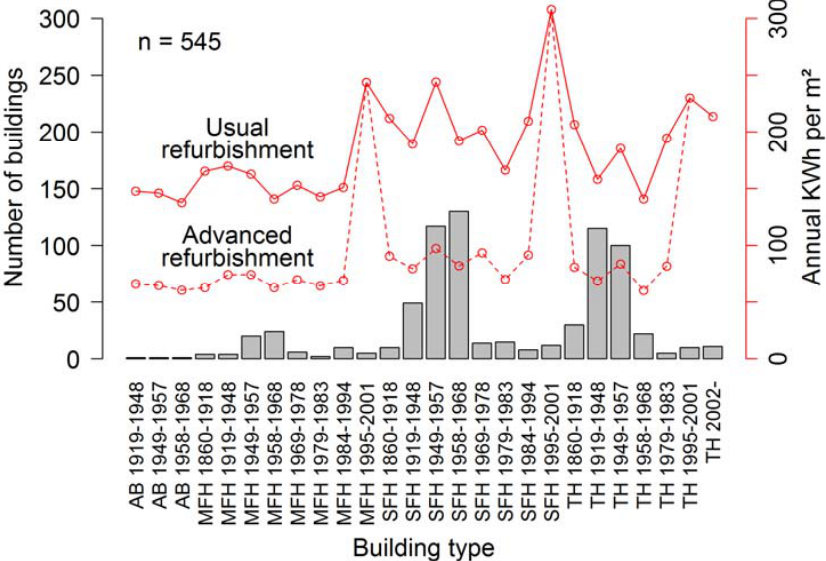
Figure 2. Number of buildings of the types Apartment Block (AB), Multi-Family House (MFH), Single-Family House (SFH) and Terraced House (TH). The building types are further